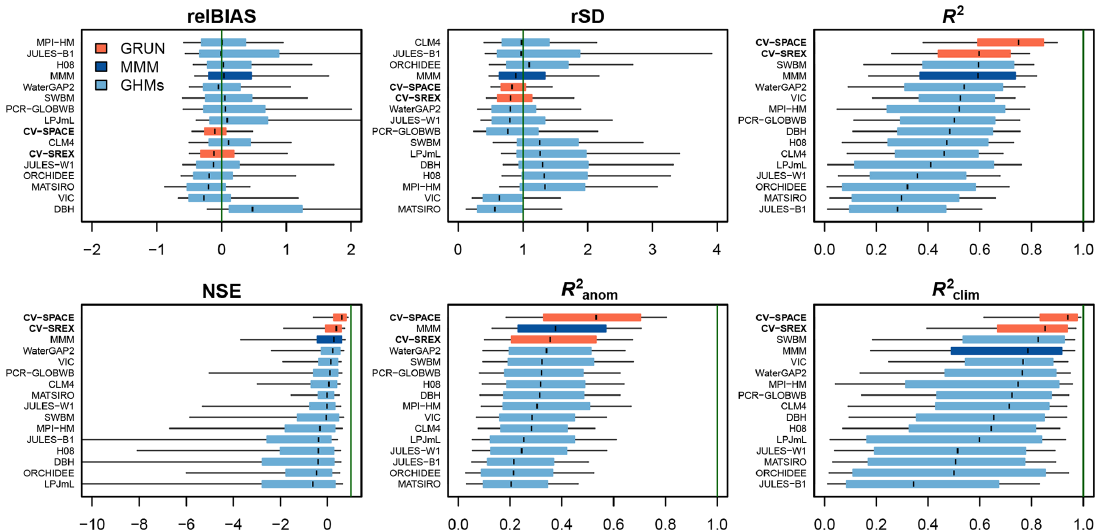
Figure 6. Benchmarking the performance of GRUN against ISIMIP2a GHM runoff simulations (“nosoc” experiment). Box plot whiskers cover the 0.1 to 0.9 quantiles of the skill score distribution. The dark green vertical lines indicate the optimal score. GRUN cross-validation results are displayed in orange, while the multi-model mean (MMM) of ISIMIP2a GHM runoff simulations is displayed in dark blue. In most of the cases, the order of the boxes follows the rank of the median skill score. However, to avoid the compensatory effect with relBIAS and rSD scores, the individual boxes are ranked based on the absolute median value of the skill score minus the optimal score. The x axis of relBIAS is left and right truncated, for rSD it is right truncated and for NSE it is left truncated.